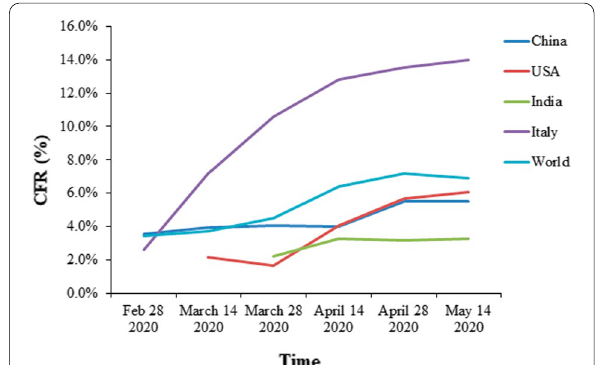
Fig. 7 The case fatality rate (CFR) from Feb-March 2020 (as per ourworldindata.org). The CFR rates may vary according to the methodology used for calculation as well as the source of data taken